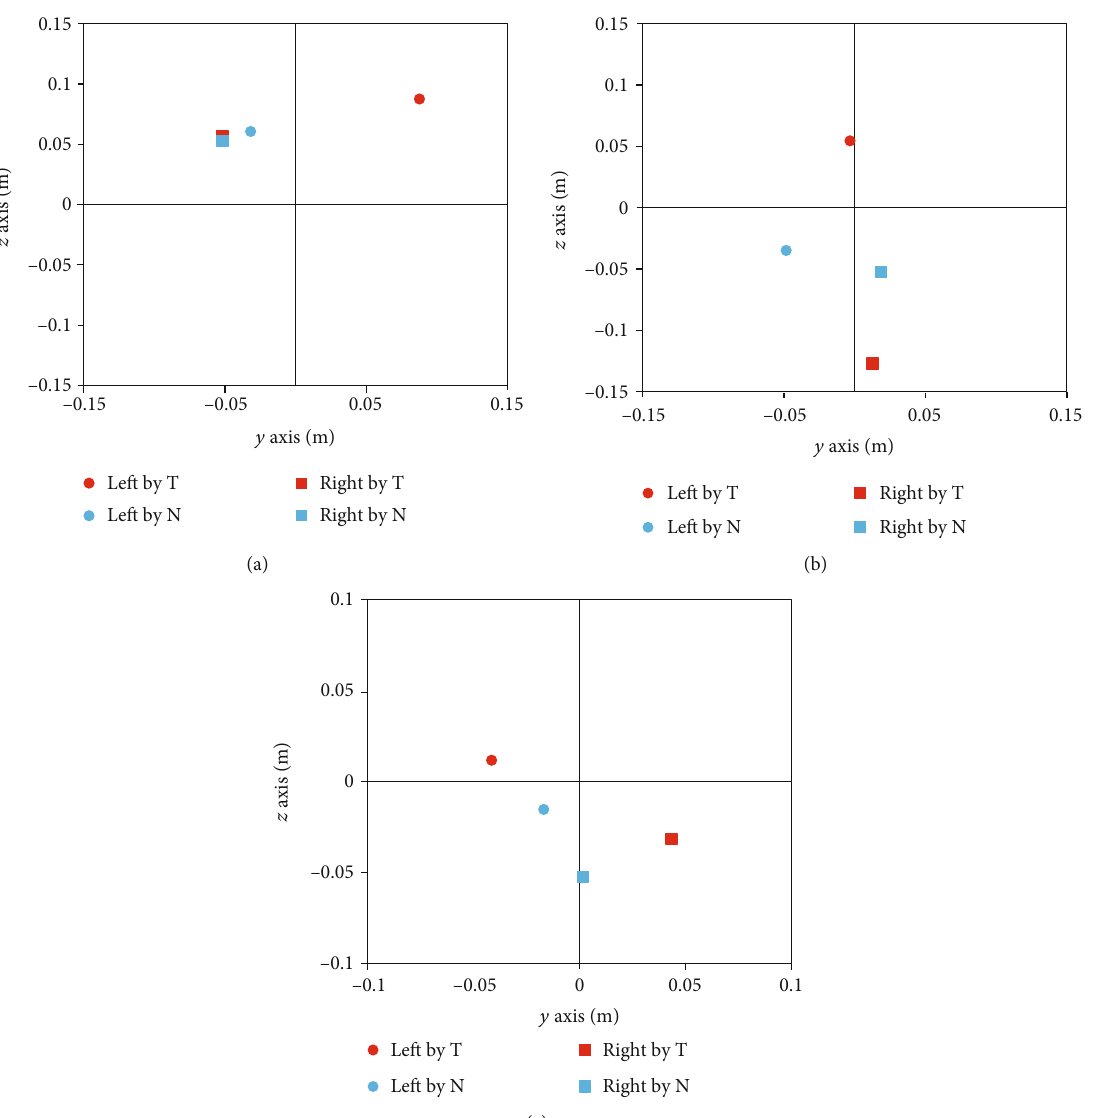
Figure 14: Relative positions between both the manipulator end e ff ectors and the desired capture points within the capture plane at the moment of impact. The red dots denote the chasers controlled using the traditional control strategy, and the blue dots denote the chaser controlled by the networks. The circular dots denote the left manipulator end e ff ectors, and the square dots denote the right manipulator end e ff ectors. (a) Case 4. (b) Case 5. (c) Case